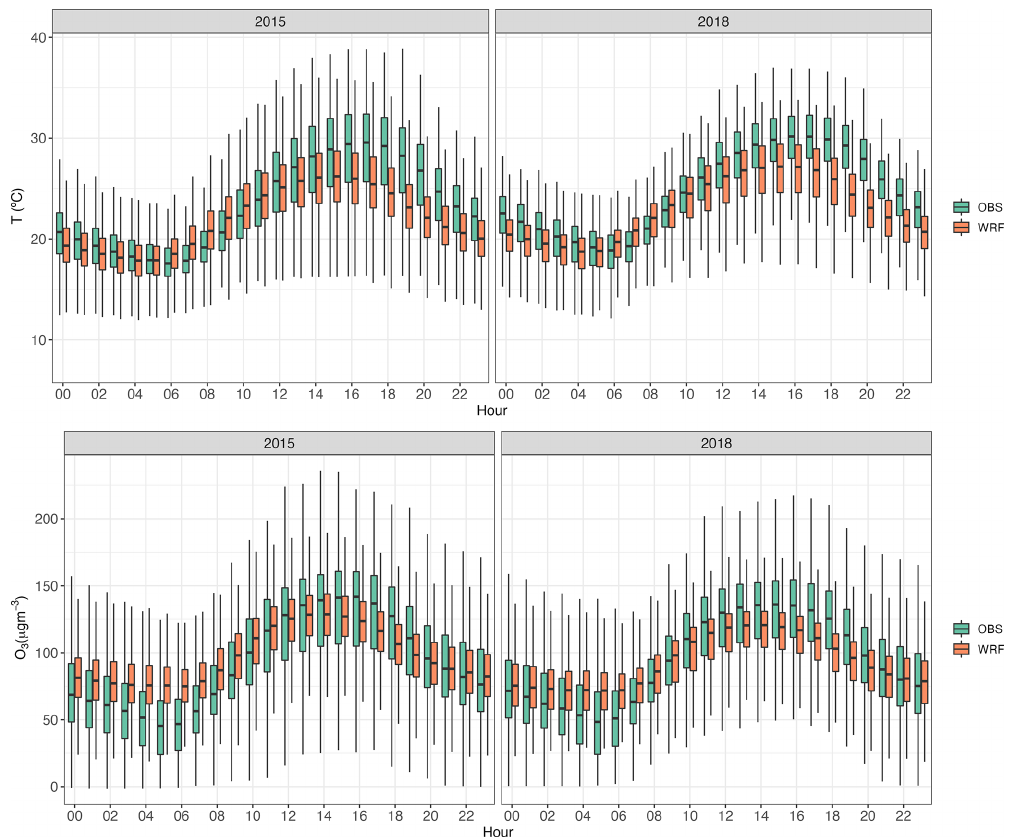
Figure 1. Observed and simulated diel percentile for temperature and O 3 over the analyzed periods at the German background stations. Note that the OBS temperature is given by ERA5 temperature extracted at the German background station locations. Vertical lines denote 5th and 95th percentiles, boxes denote 25th and 75th percentiles, and the black line in the boxes denotes the 50th percentiles.